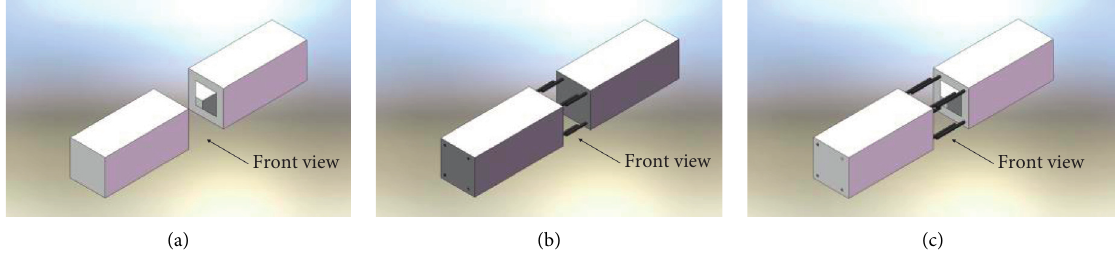
Figure 3: Assembly diagram of the experiment specimens. (a) Type 1. (b) Type 2. (c) Type 3.